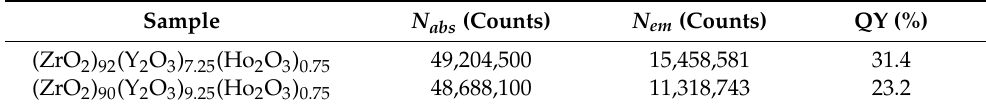
Table 3. The quantum yields of the (ZrO 2 ) 92 (Y 2 O 3 ) 7.25 (Ho 2 O 3 ) 0.75 and (ZrO 2 ) 90 (Y 2 O 3 ) 9.25 (Ho 2 O 3 ) 0.75 crystals.